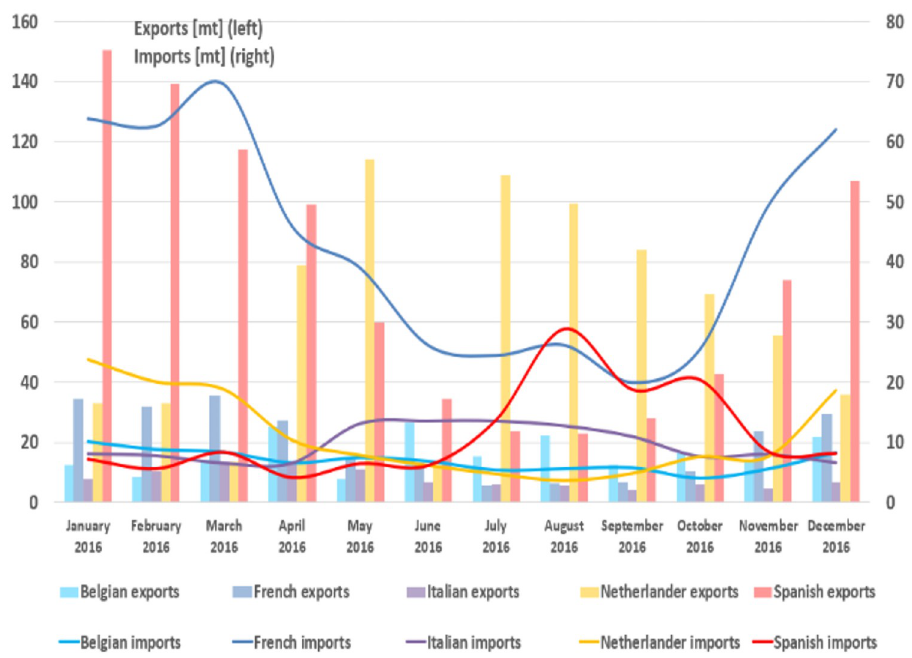
Fig 9. Seasonal imports/exports of the main tomato re-exporters in the European market